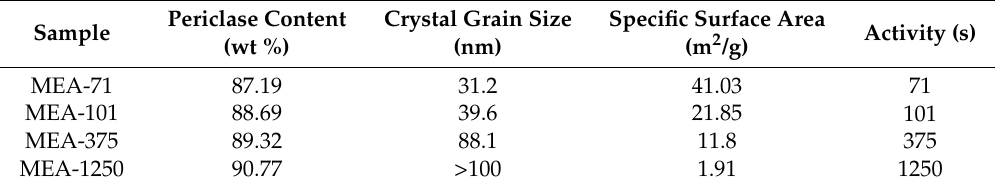
Table 2. Physicochemical properties of MEAs.